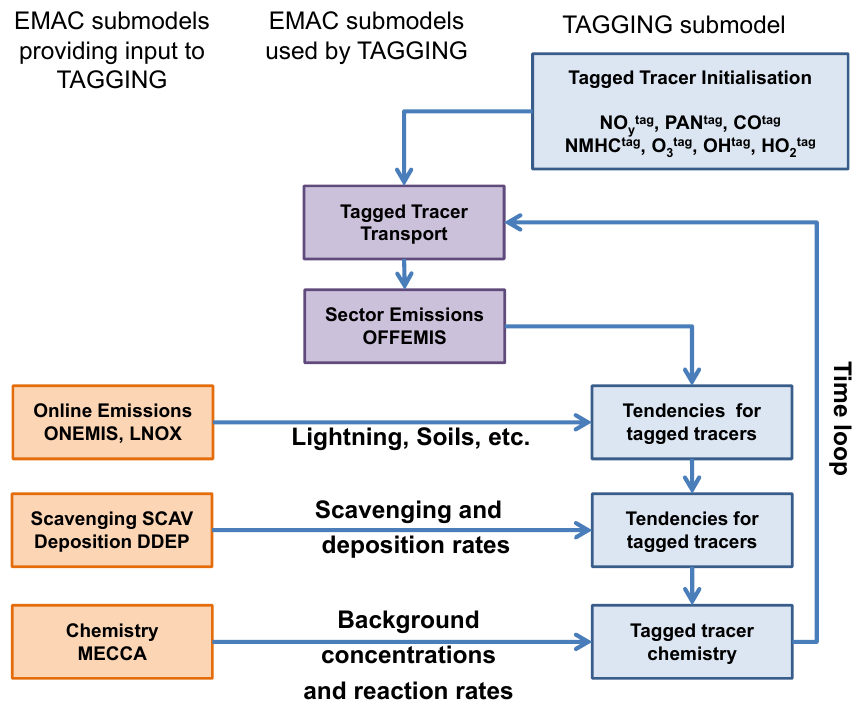
Figure 1. Sketch of the tagging